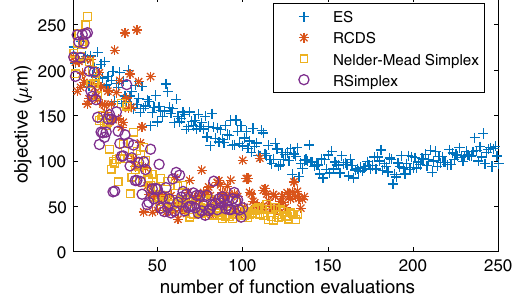
FIG. 7. History of the objective function ( σ x þ 3 σ y of the turn- by-turn beam position oscillation in the first 256 turns after the kickers are fired) for the kicker bump matching experiments for four optimization algorithms: Extremum Seeking (ES, plus), RCDS (asterisk), Nelder-Mead simplex (squares), and RSimplex (w/o simplex rebuilding,